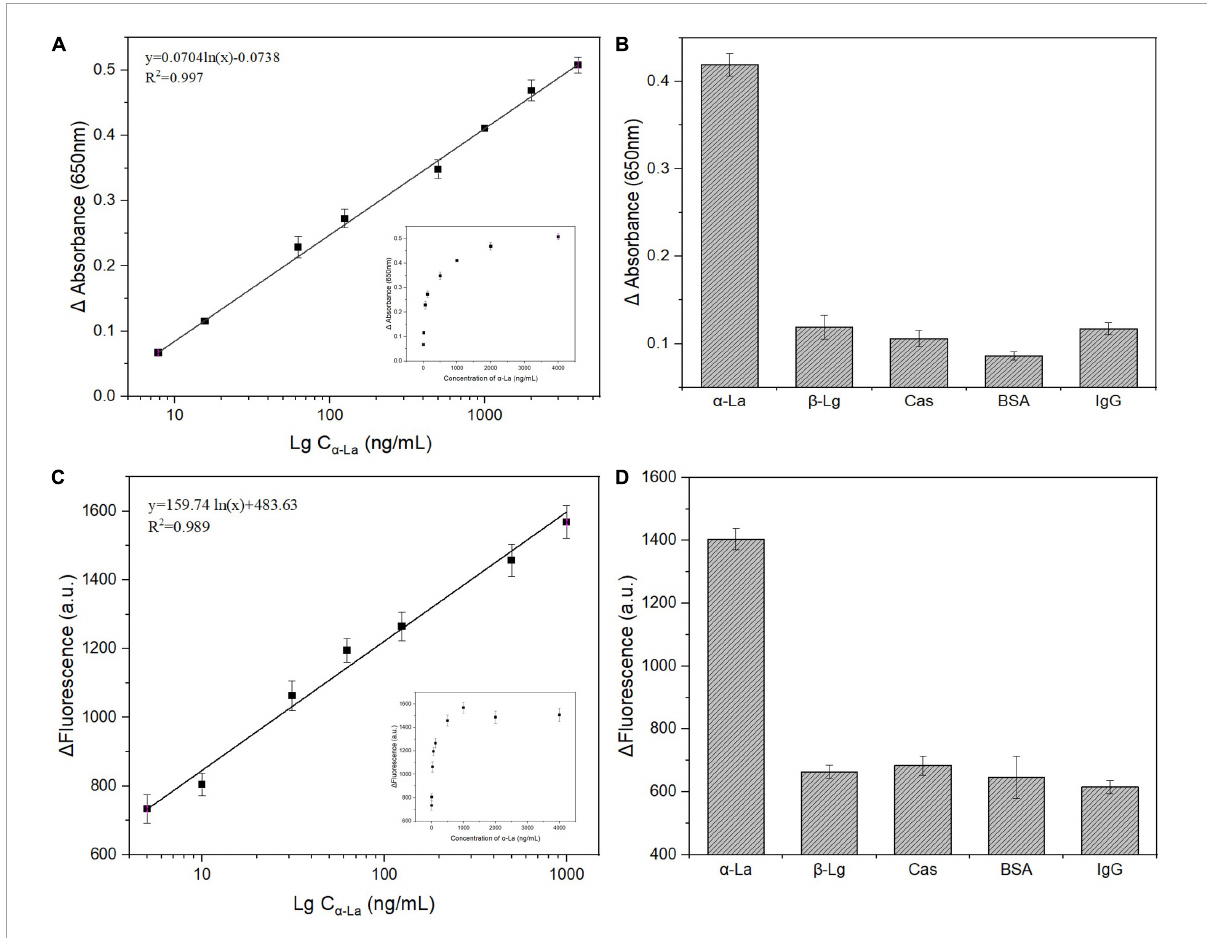
FIGURE5 Linear calibration plot between absorbance (A) and fluorescence intensity (C) versus the logarithm of α -lactalbumin ( α -La) concentrations; Selectivity of proposed colorimetric (B) and fluorescence (D) strategy for α -La detection (1 µ g/ml) alone or coexisting with 5 µ g/ml of other